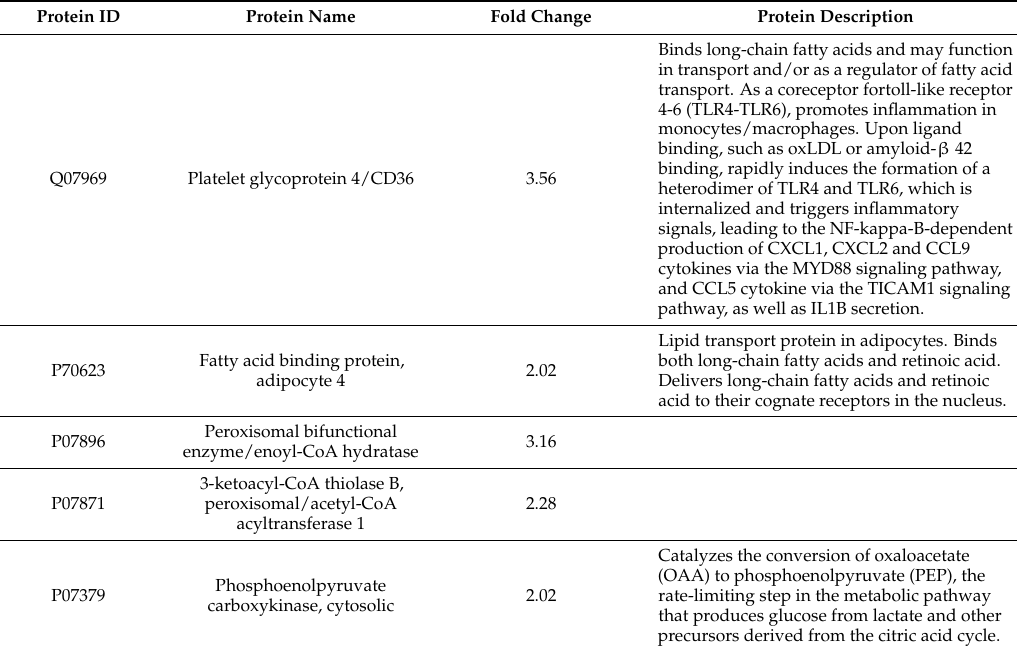
Table 3. Regulated proteins in the PPAR signaling pathway identified by using the UniProt database. Protein